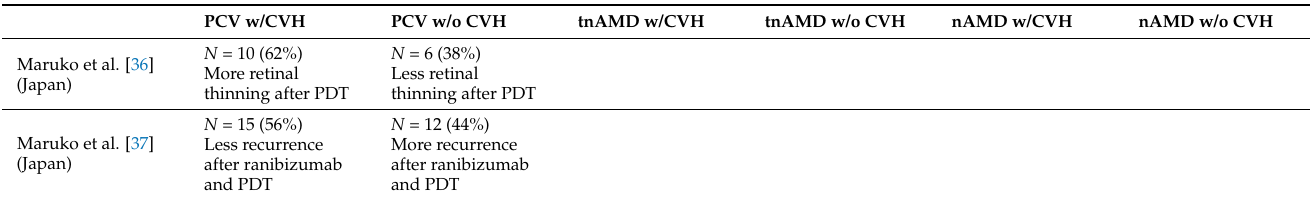
Table 5. Association of CVH with treatment outcome of